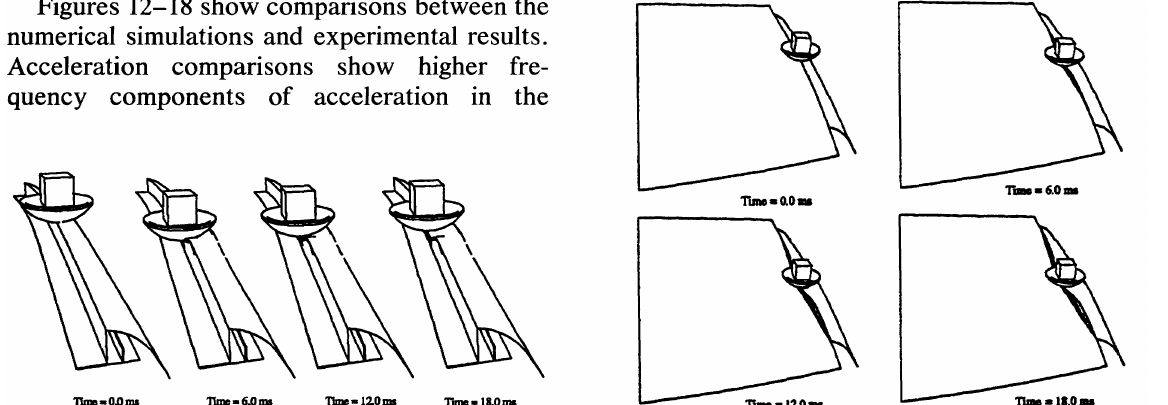
FIGURE 10 Modified Taurus hood/fender model: